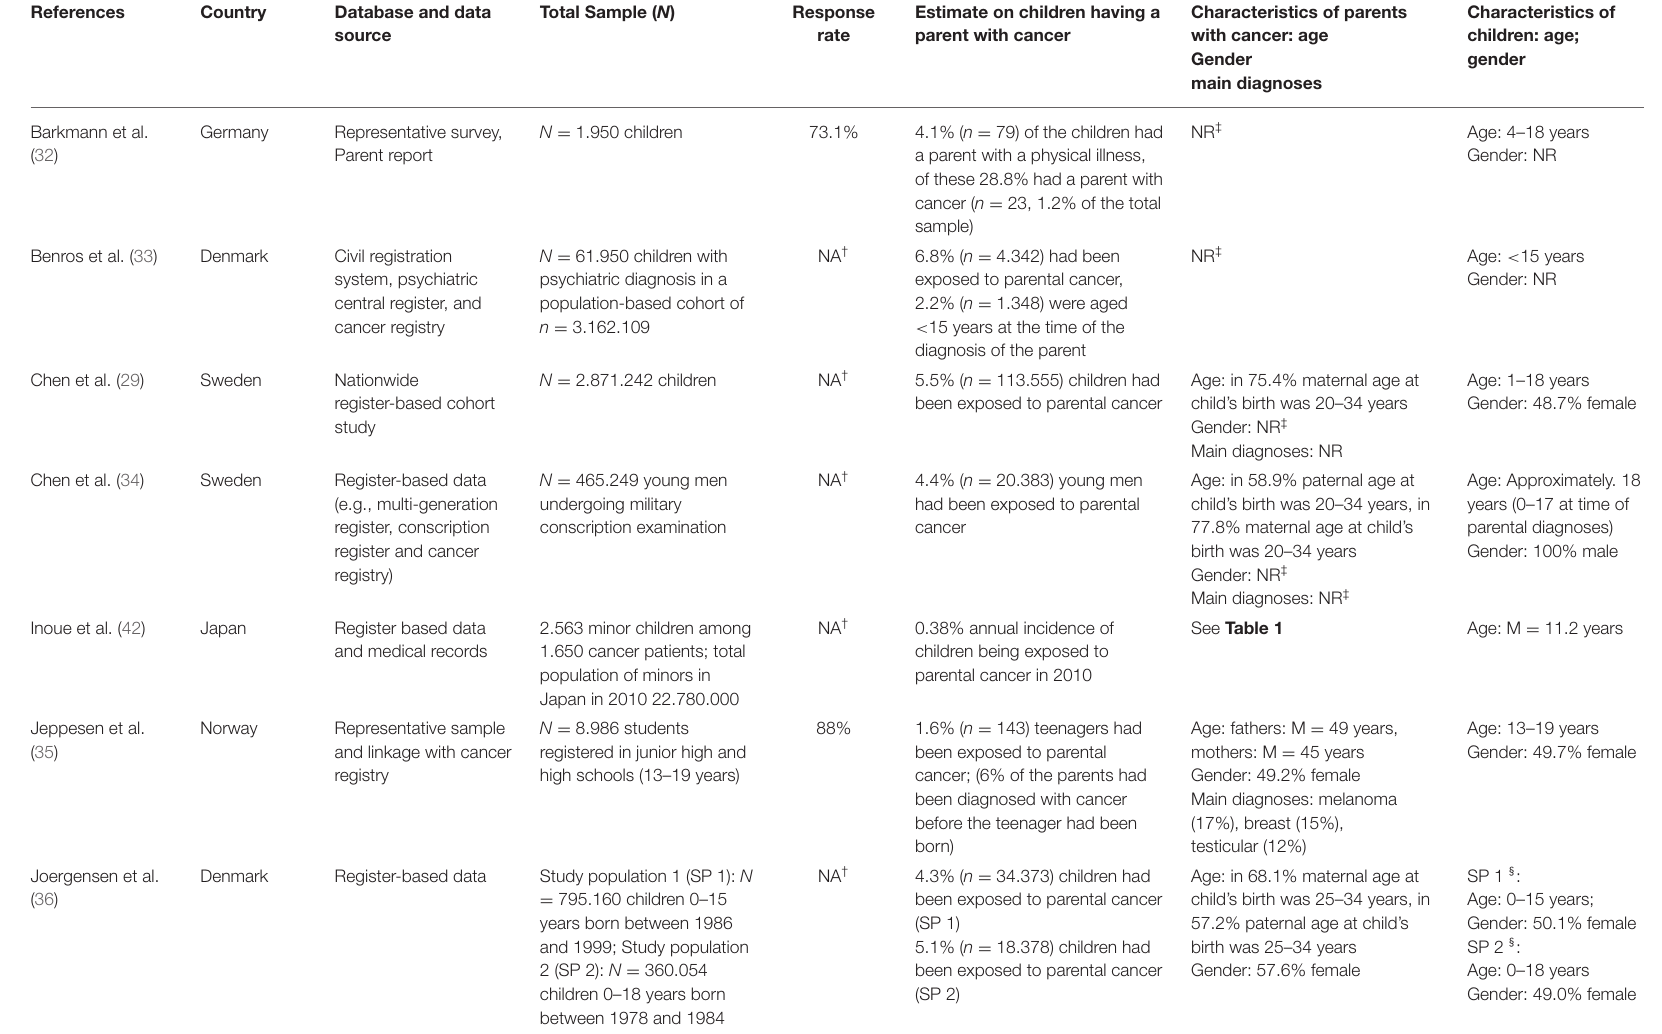
TABLE 2 | Study characteristics and estimates of children and/or young adults having a parent with cancer from n = 13